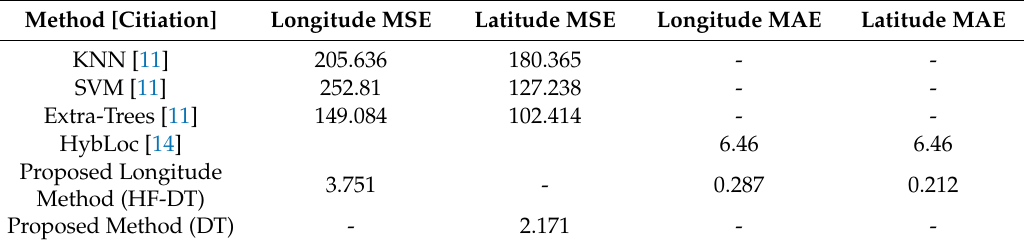
Table 13. Comparison of positioning